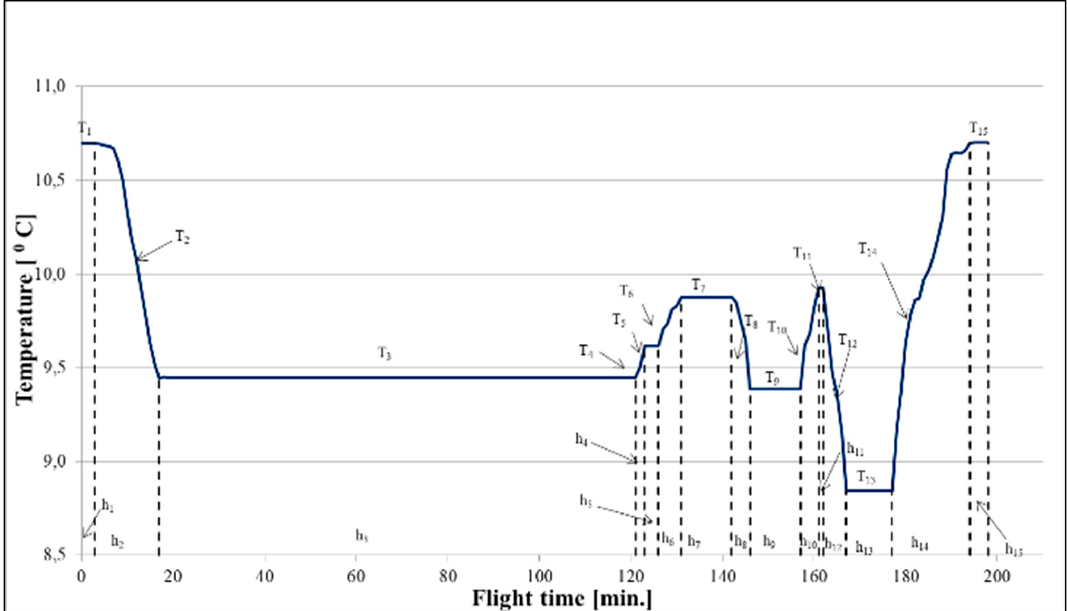
Figure 10. Mean temperature profile for the SW-4 helicopter for the period from 1 January 2017 until 31 December